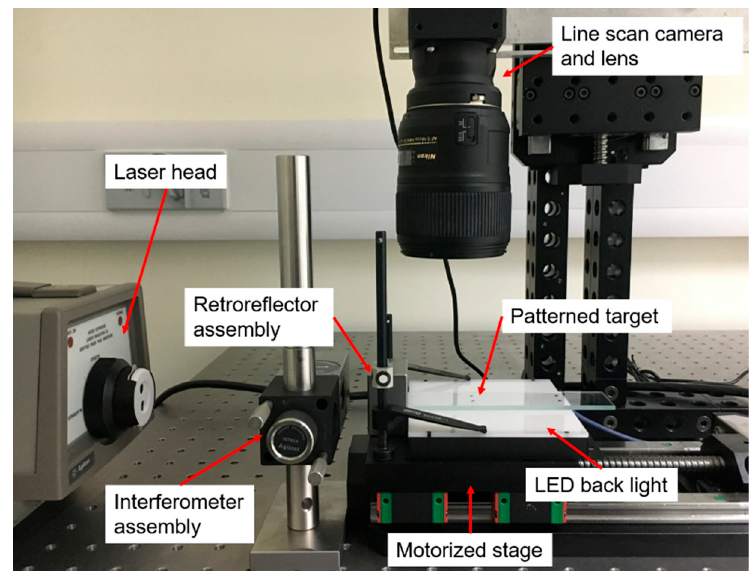
Figure 3. Image grating system configuration. LED: light ‐ emitting diode.